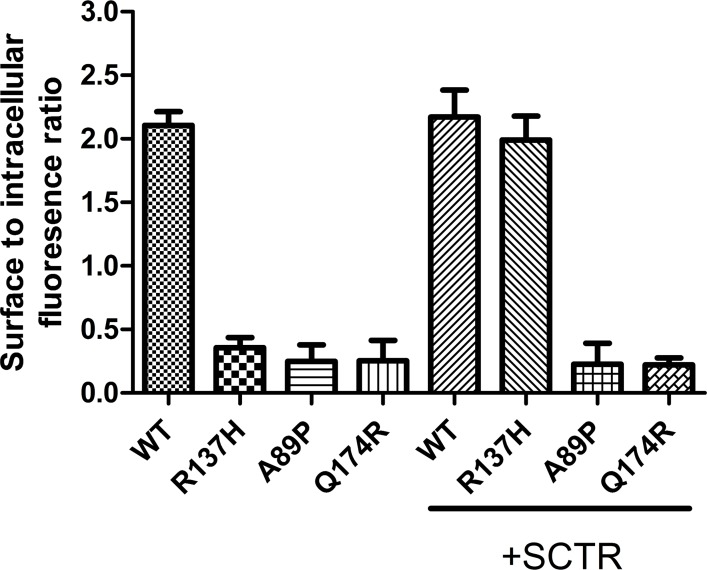
Surface to intracellular fluorescence ratio for cell expressing WT/mutant AVPR2 with or without SCTR co-expression.The presence of SCTR increased the amount of fluorescence on the cell surface in cell expressing R137H AVPR2 tagged with YFP, indicating a rescue of the mutant receptor. The data were mean±SEM from three independent experiments from 5–6 ROIs per sample.